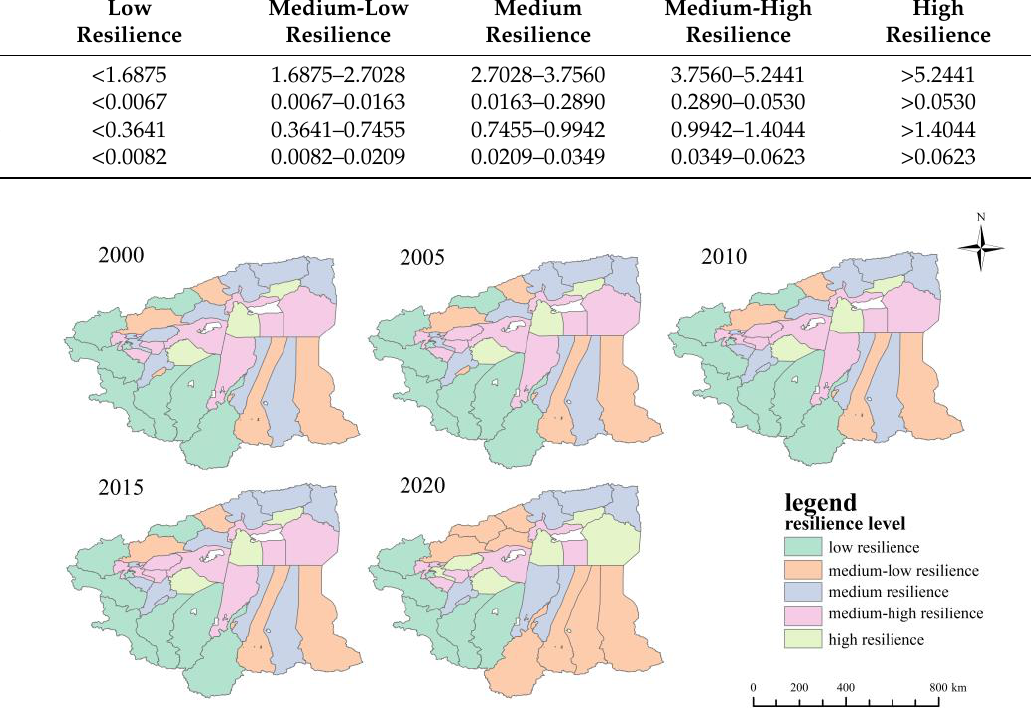
Figure 5. Scale resilience level distribution of four prefectures in southern Xinjiang from 2000 to